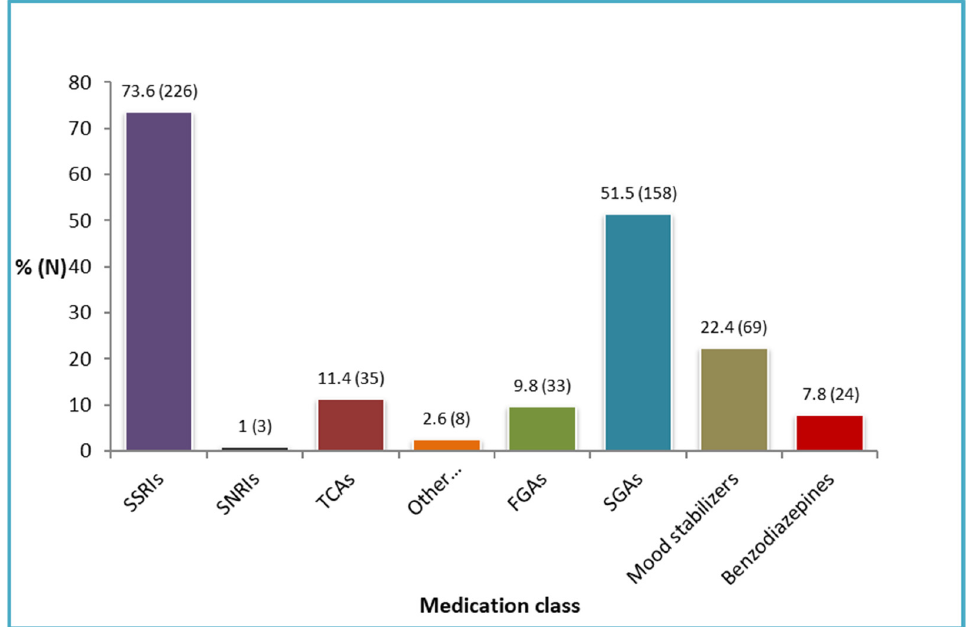
Figure 1. Frequency of psychotropic medications classes ( n = 307). As for individual psychotropic drugs, the most commonly prescribed among SSRIs were citalopram and fluoxetine (52.2% and 28.2%, respectively), among TCAs were meli- tracen and amitriptyline (51.4% and 37.1%, respectively) among FGAs was flupentixol (78.8%), among SGAs were quetiapine and olanzapine (46.2% and 27.9%, respectively), among mood stabilizers were valproate and lamotrigine (39.1% and 30.4%, respectively) and among benzodiazepines was bromazepam (70.8%) (Table 2).